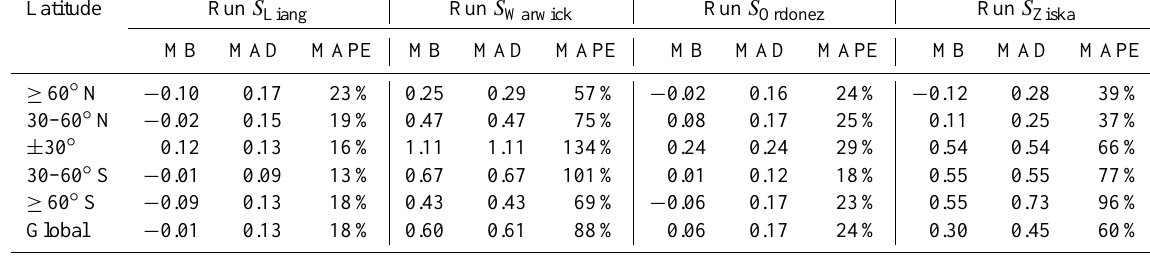
Table 6. As Table 5 but for CH 2 Br 2 . Latitude Run S Liang